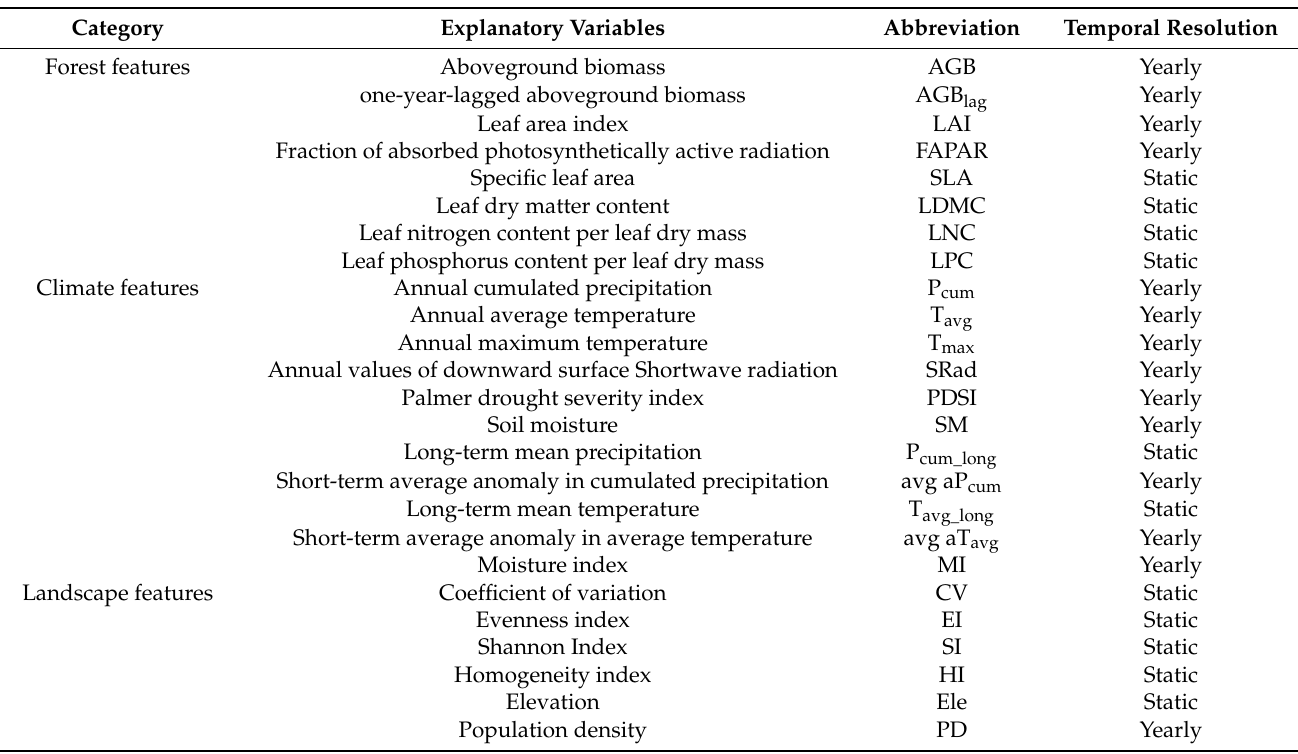
Table 1. Explanatory variables used in vulnerability